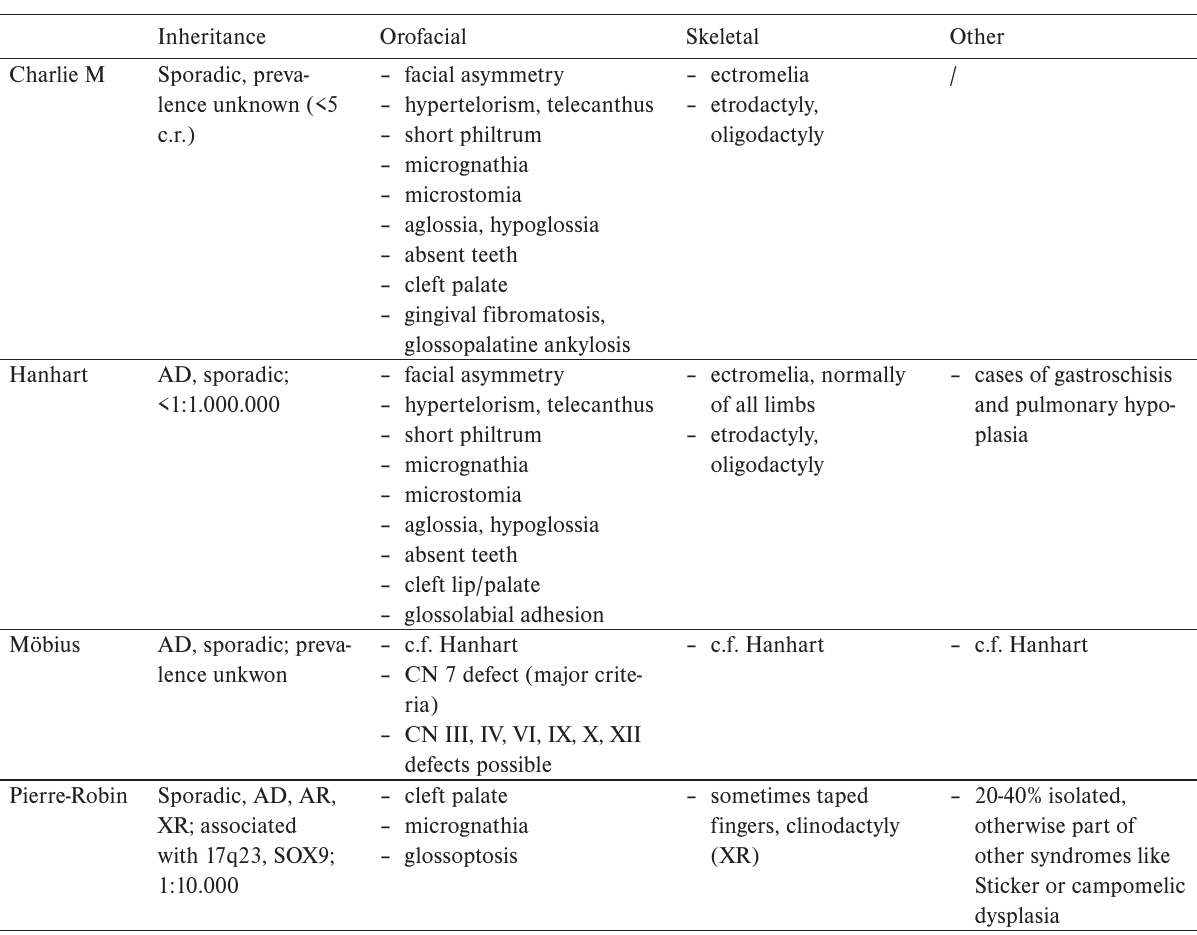
Table 3. Overview and phenotypical description of type V (Hall)/type IV (Chicarilli) OLHS syndromes without amniotic band syndrome (c.r.: case reports, AD: autosomal dominant, AR: autosomal recessive, XR: X-linked recessive).